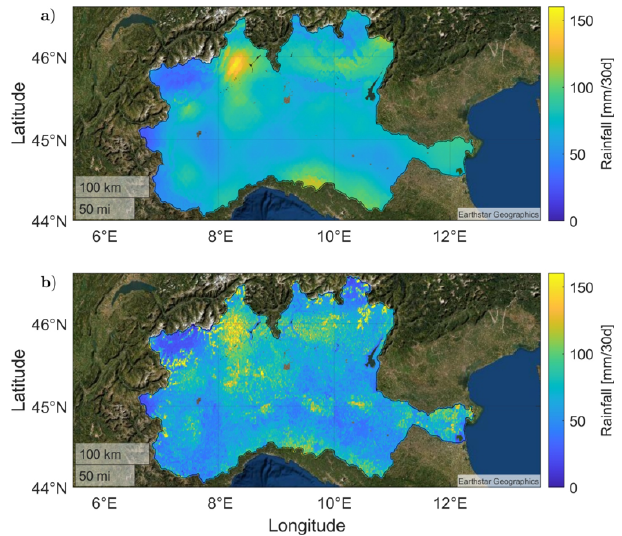
Figure 2. Estimated average 30d accumulated rainfall from the parameterized SM2RAIN applied to ASCAT (a) and S1-RT1 (b) SM product for the period 2016–2019. Map copyright © 2021 GeoBasis-De/BKG (© 2009), Google, Inst. Geogr. Nacional Im- magini © 2021